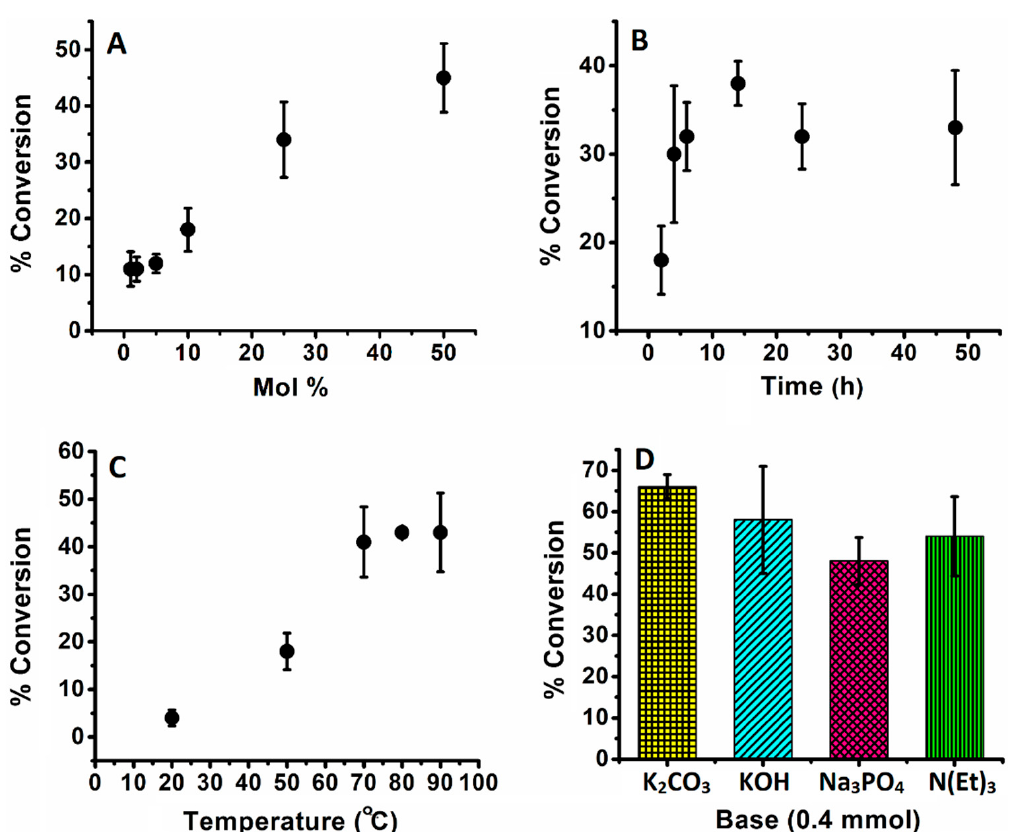
Figure 5. ( A ) Effect of amount of catalyst in hydroxylation of phenyl boronic acid to phenol. Reaction conditions: phenyl boronic acid (0.1 mmol), H 2 O (5 mL), 50 °C, 2 h. ( B ) Effect of reaction time in hydroxylation of phenyl boronic acid to phenol. Reaction conditions: phenyl boronic acid (0.1 mmol), catalyst (10 mol%), H 2 O (5mL), 50 °C. ( C ) Effect of reaction temperature in hydroxylation of phenyl boronic acid to phenol. Reaction conditions: phenyl boronic acid (0.1 mmol), catalyst (10 mol%), H 2 O (5 mL), 6 h. ( D ) Effect of different bases in hydroxylation of phenyl boronic acid to phenol. Reaction conditions: phenyl boronic acid (0.1 mmol), catalyst (10 mol%), H 2 O (5 mL), 70 °C, 6 h.